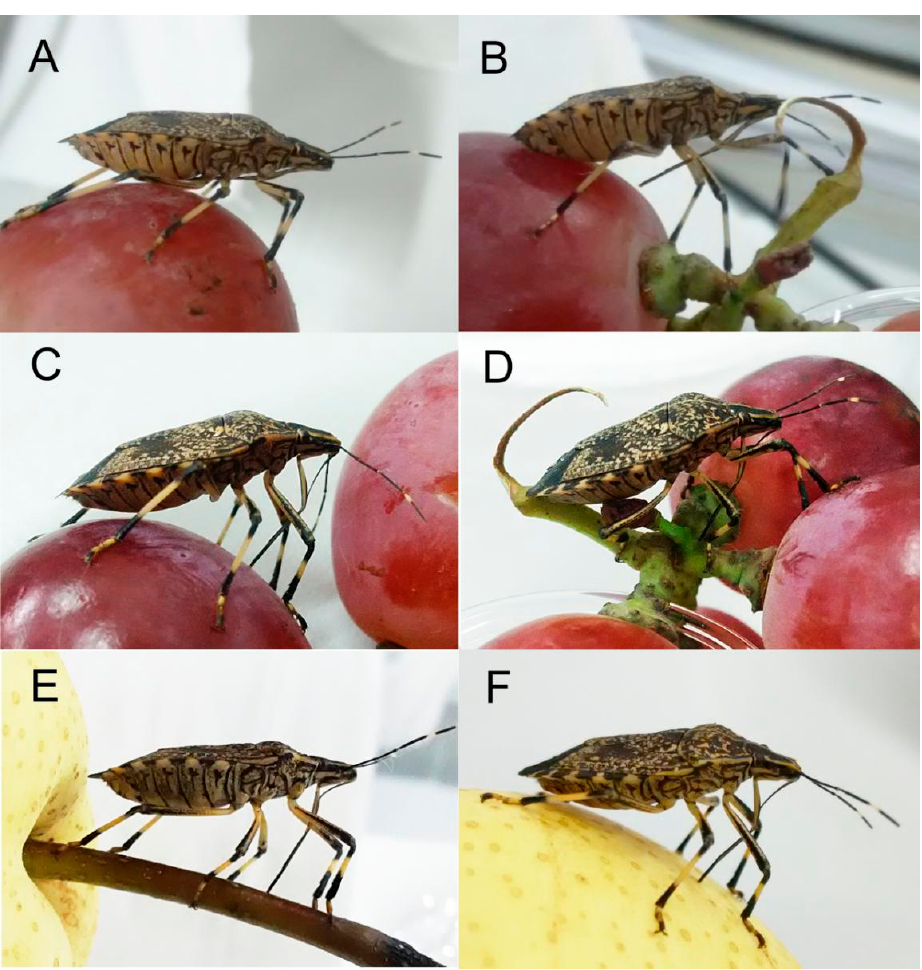
Figure 11. Feeding on fruits and young stalks in adult E. fullo showing positions of the mouthparts. ( A ) At rest or not feeding; ( B ) Exploring suitable feeding location; ( C ) Feeding on grape; ( D ) Feeding on green stalk of grape; ( E ) Feeding on stalk of pear; ( F ) Feeding on pear.